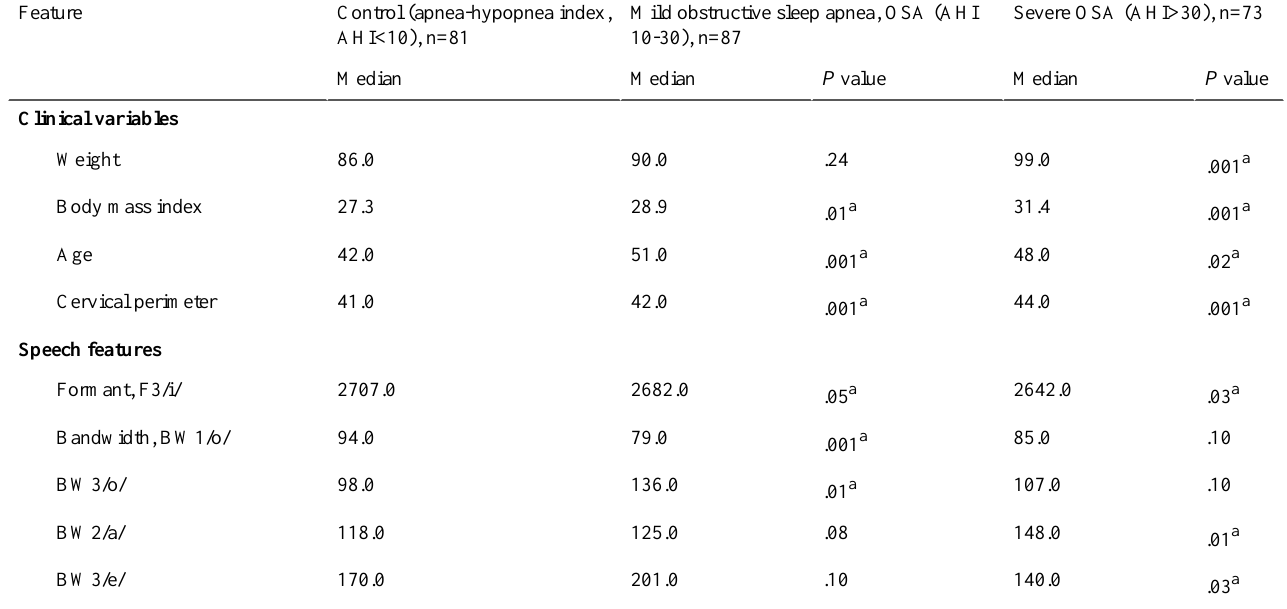
Table 9. Contrast among control and obstructive sleep apnea (OSA) severity groups on a male (N=241) population.